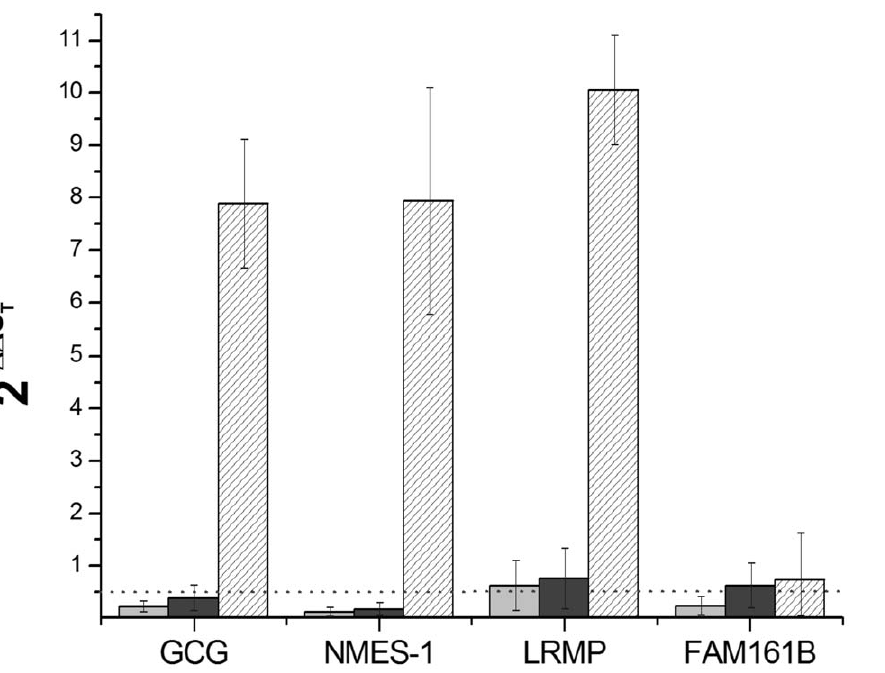
Figure 3. The expression of GCG , NMES-1 , LRMP , and FAM161B genes, tested on independent laser microdissected colonic and also on demethylated HT-29 cells by real-time PCR. Data analysis was carried out with the comparative Cp method (see Materials and Methods). Genes were considered to be downregulated with 2 { DD CP values lower than 0.5 (50% decrease, horizontal dotted line), and upregulated with values higher than 2 (two-fold increase). GAPDH was used as a control housekeeping gene. Light grey and dark grey columns show gene expression levels in adenoma and in tumor samples relative to normal samples, respectively. Hatched columns indicate the comparison of 5-Aza treated and control cells. Standard deviations of the measured transcript levels were calculated and are indicated for each transcript. Housekeeping gene intensities were averaged for each group.